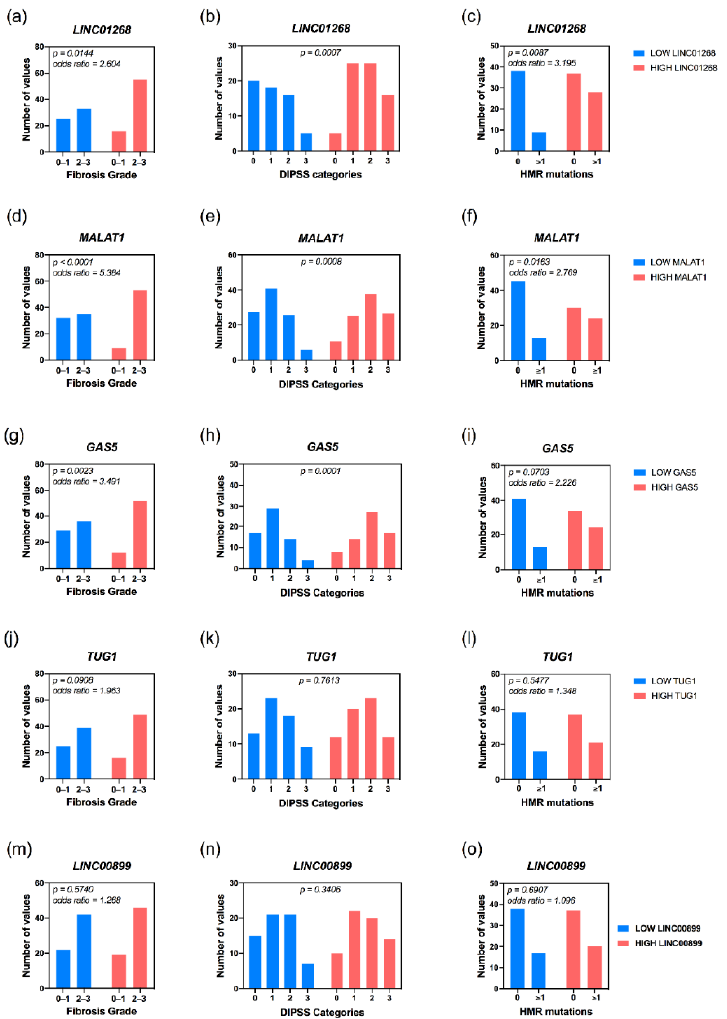
Figure 4. Correlation analysis of level of circulating lncRNAs with fibrosis and mutational status of MF patients. Histograms obtained from contingency tables computed to correlate lncRNAs plasma levels and prognostic estimates such as fibrosis grade ( a , d , g , j , m ), assignment to DIPSS categories ( b , e , h , k , n ) and HMR mutations ( c , f , i , l , o ). Samples with low or high levels of target RNA are represented in blue and red, respectively. p = p -value was computed by Fisher’s exact test or the Chi-square ( χ 2 ) test.